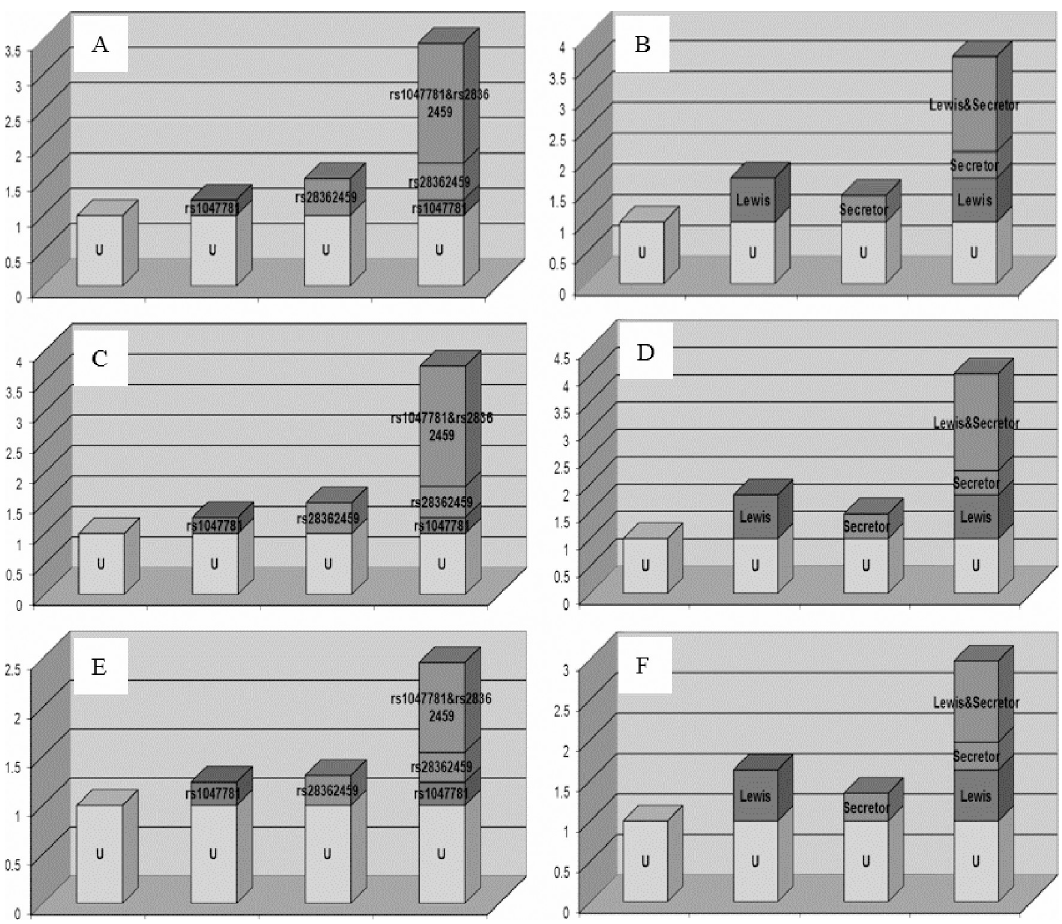
Fig 1. Additive interactions between rs1047781 and rs28362459, and Lewis status and secretor status. (A, C, and E) Interactions on an additive scale between rs1047781and rs28362459 for total participants, male subgroup, and female subgroup, respectively. (B, D, and F) Interactions on an additive scale between Lewis status and secretor status for the total participants, the male subgroup, and the female subgroup, respectively.